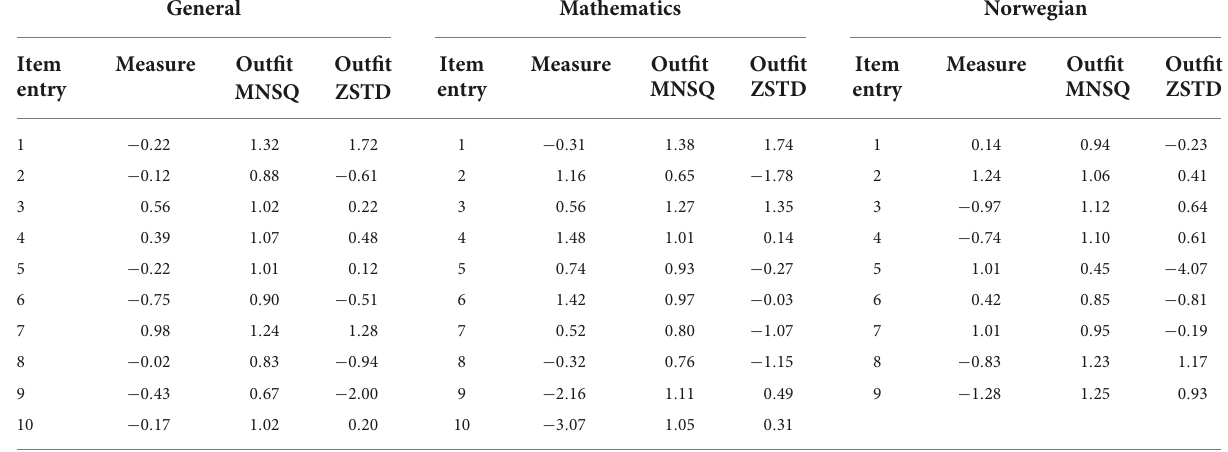
TABLE 1 Fit statistics for the mixed